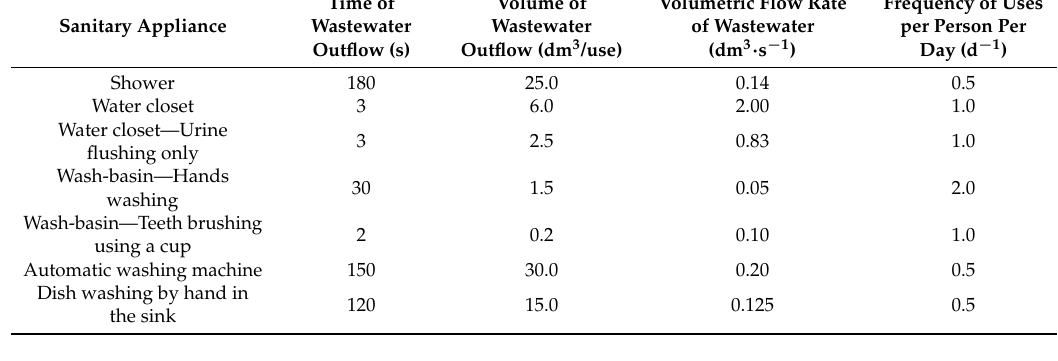
Table 2. Assumed values of parameters describing appliances used in a typical household [47].